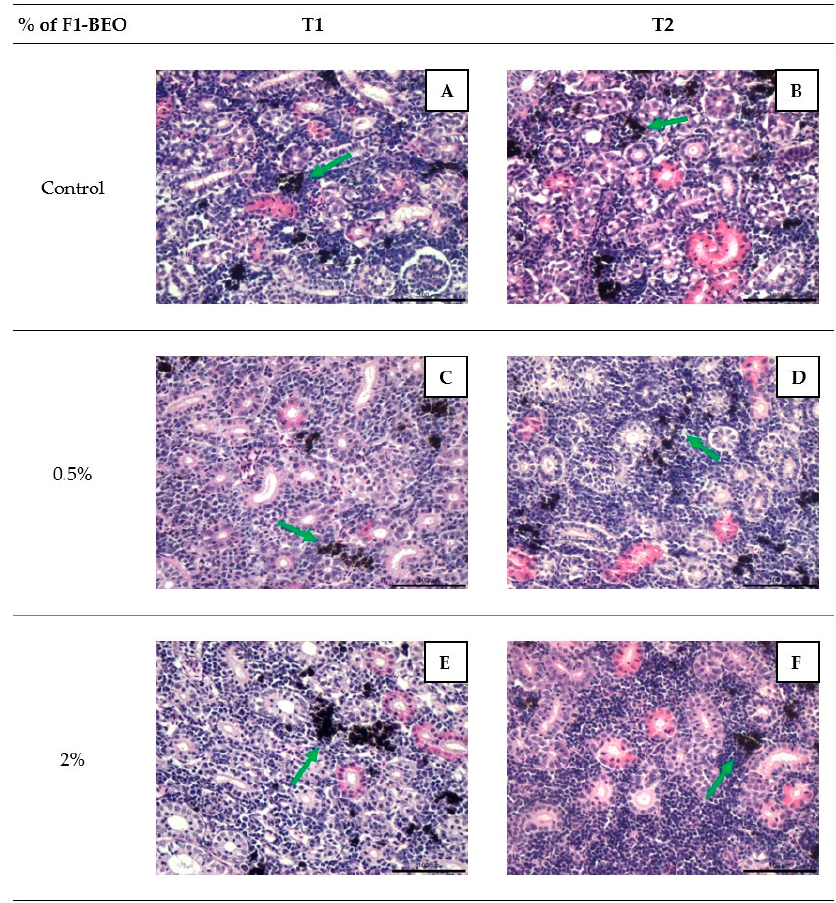
Figure 3. Histology using hematoxylin-eosin staining, evaluating the morphology of kidney specimens belonging to the control groups ( A , B ), 0.5% groups ( C , D ) and 2% groups ( E , F ). Green arrows indicate the melano-macrophages. Magnification: 20×.